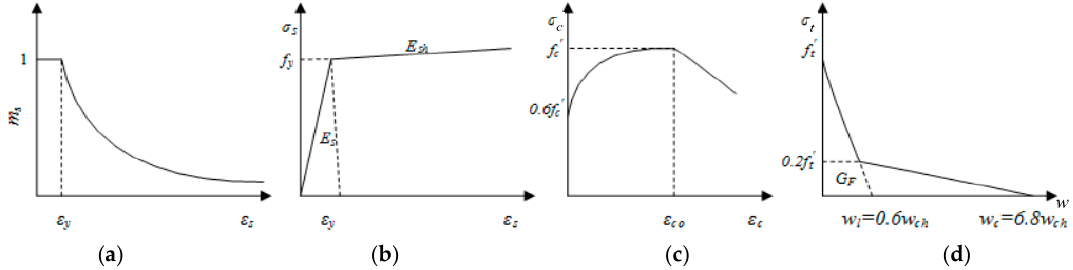
Figure 5. ( a ) Modifier m s as a function of the bar strain; ( b ) steel stress–strain constitutive relationship; ( c ) compressive hardening and softening laws; ( d ) tensile softening law.